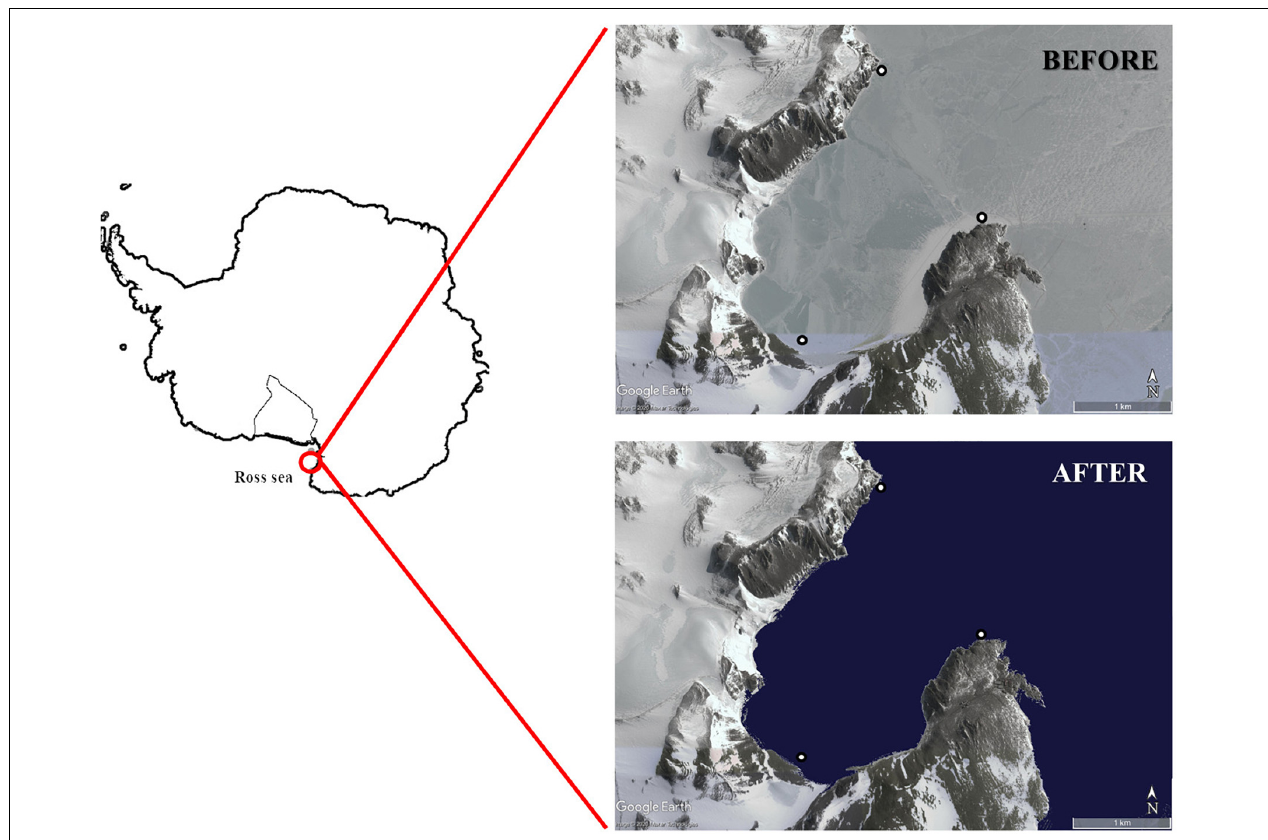
FIGURE 1 | Sampling sites in Tethys Bay (Terra Nova Bay, Ross Sea). The background image of Tethys Bay was obtained from Google